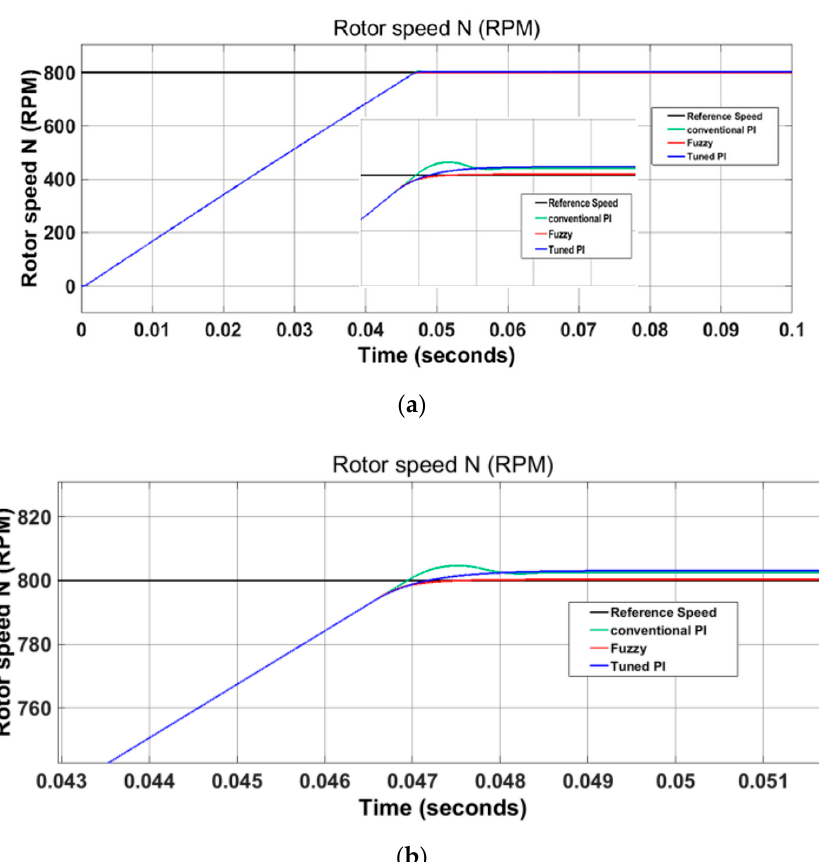
Figure 18. ( a ) Comparison of speeds for various controllers; ( b ) expanded view for various controllers. Table 5. BLDC motor parameters.